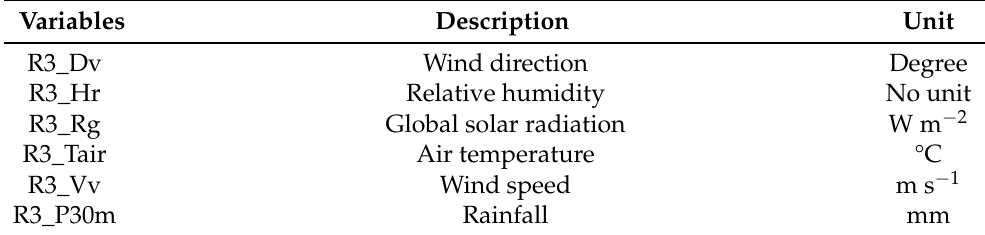
Table 1. Meteorological station data